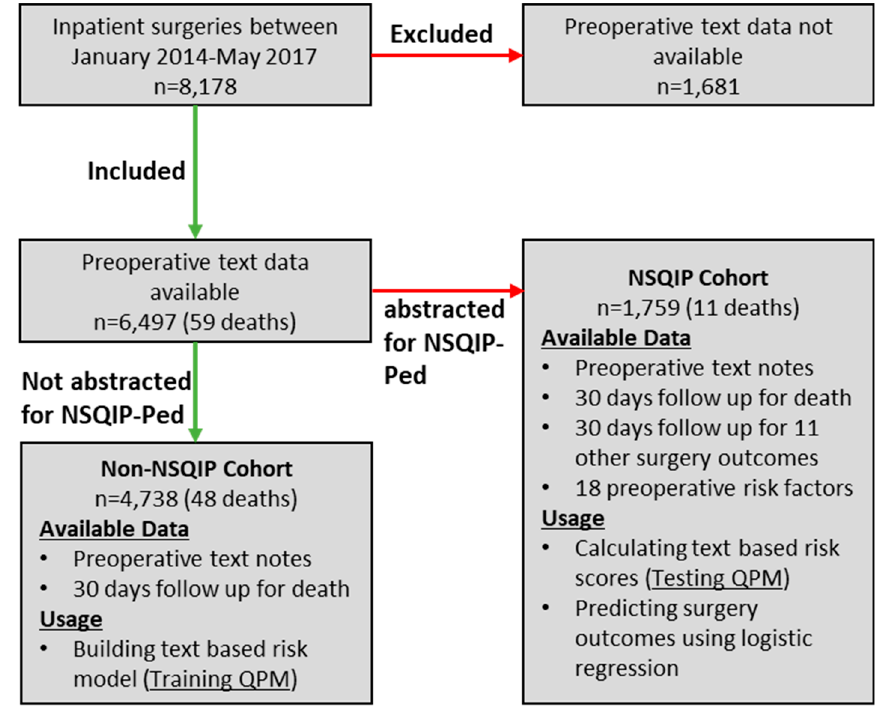
Figure 1 . Summary of NSQIP (training) and non-NSQIP (testing) cohorts’ determination and methods.